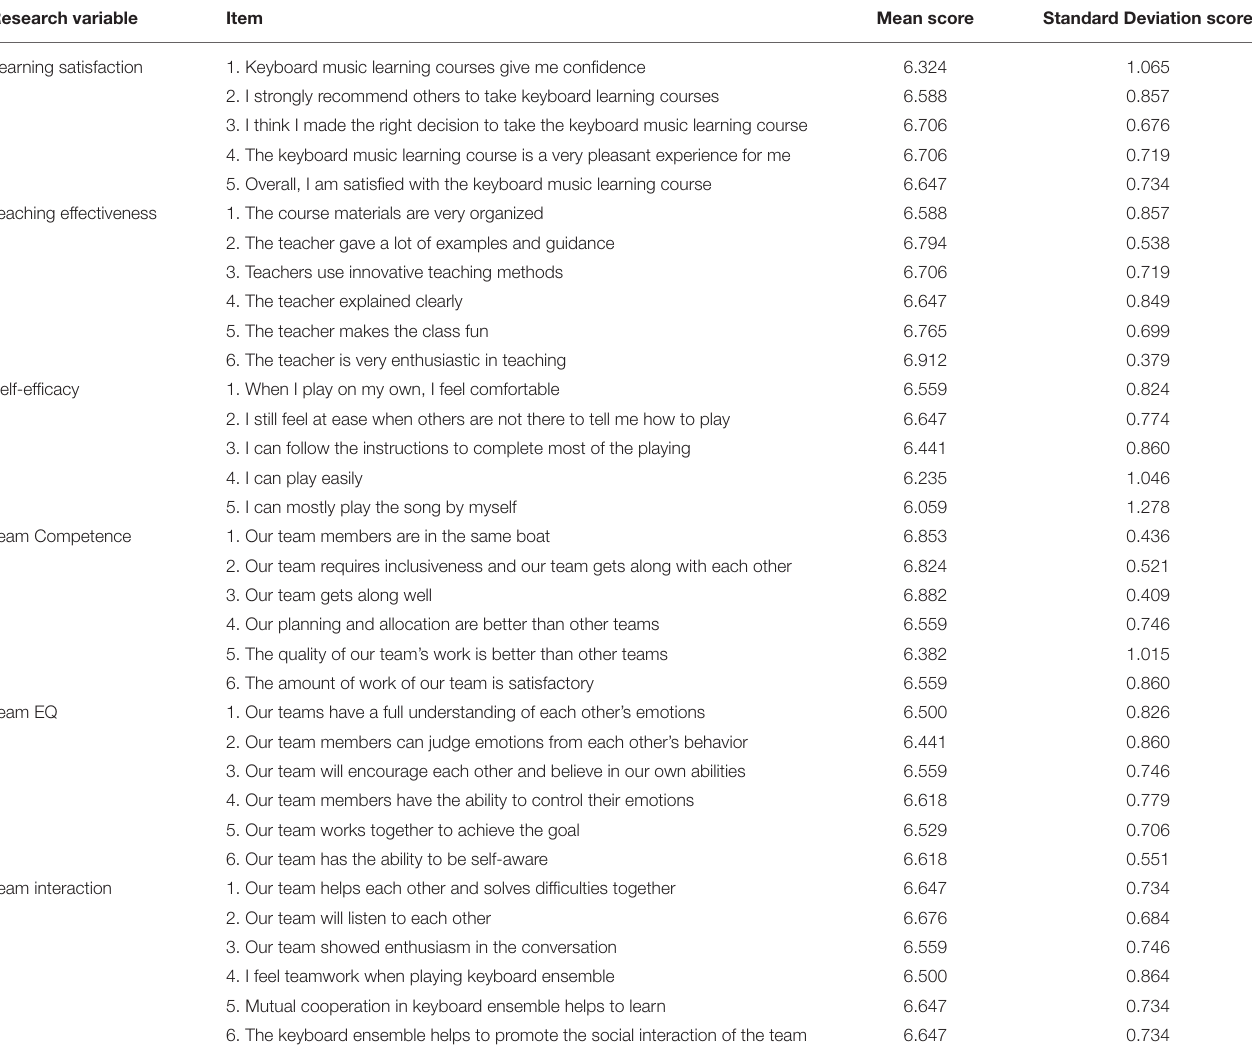
TABLE 3 | Item average and standard deviation analysis